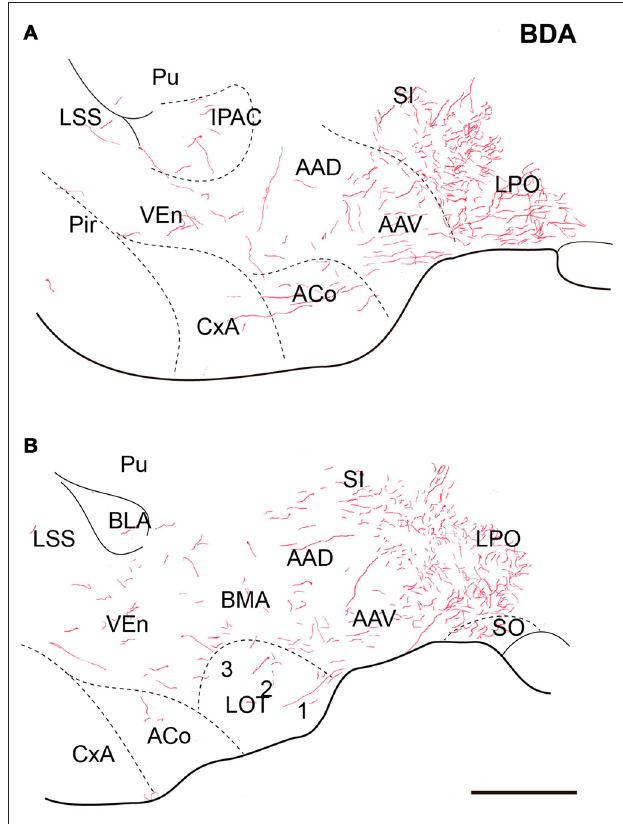
FIGURE 4 | Distribution of anterograde fiber labeling in the sublenticular extended amygdala (SLEA) after a BDA injection into the NI. Labeled fibers mainly occurred in the medial aspects of the SLEA. (A) Corresponds to Bregma − 0–72.pdf (B) Corresponds to Bregma − 0.84 mm. Calibration bar 250 µ